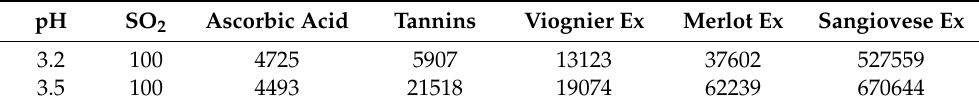
Table 2. Percentage relative antioxidant activity (RAA) as radical scavengers of commercial products and UG extracts in the DPPH assay, at two different pH levels, with reference to SO 2 .